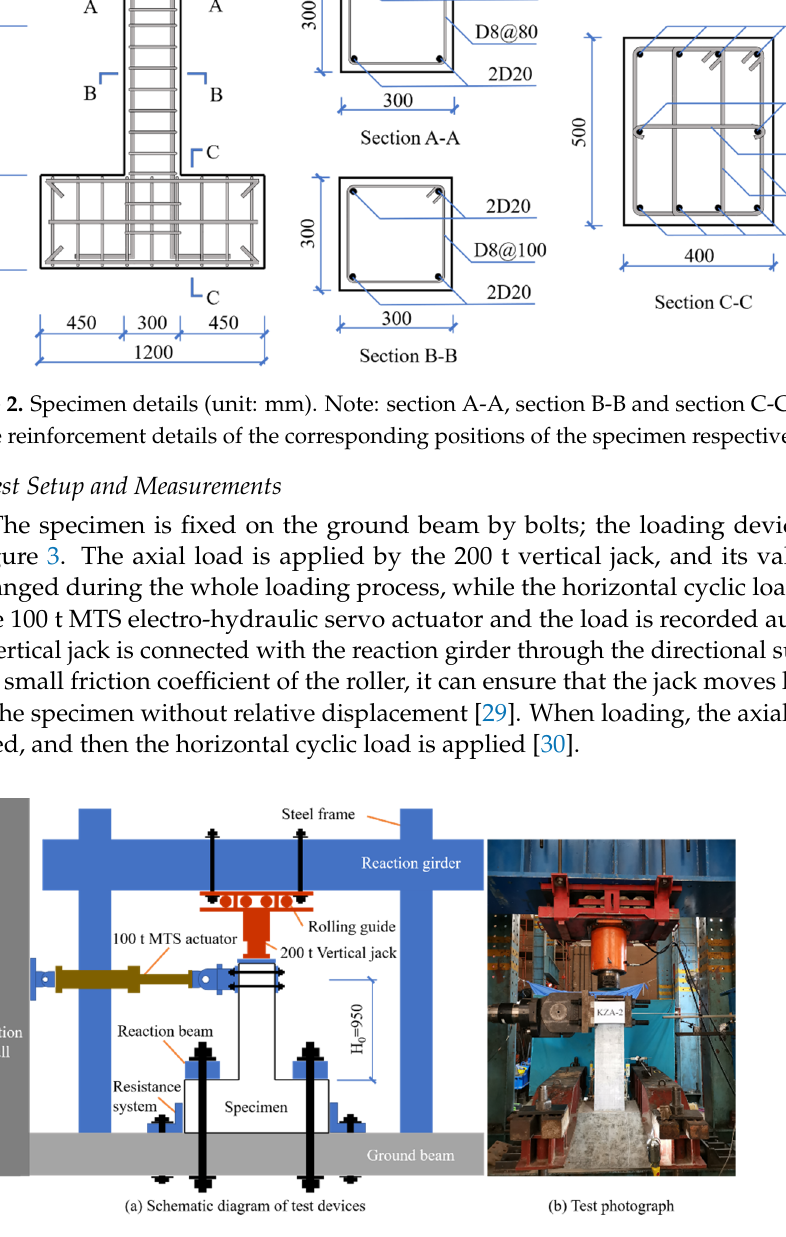
Figure 3. Test apparatus. Figure 3. Test